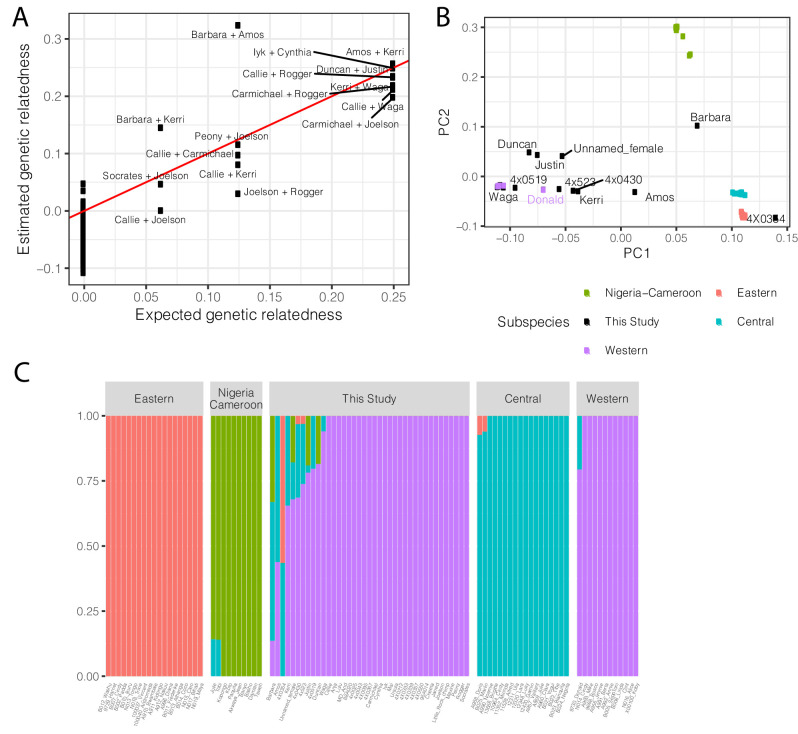
Population structure and relatedness of chimpanzee cohort based on whole genome sequencing genotyping.(A) Scatter plot of the expected and observed genetic relatedness of each pair of chimpanzees for which we have pedigree information. We expected eight first-degree relationships (relatedness = 0.25), five second-degree relationships, and three third-degree relationships. (B) The chimpanzees sequenced in this study are generally Western chimpanzees, although recent admixture with other subspecies is prevalent for many of these captive-born chimpanzees. Principle component analysis of genotypes of newly sequenced and previously sequenced (de Manuel et al., 2016) chimpanzees. Individuals colored by subspecies for previously sequenced chimpanzees (Eastern, Pan troglodytes schweinfurthii; Western, Pan troglodytes verus; Central, Pan troglodytes troglodytes; Nigeria-Cameroon, Pan troglodytes ellioti). Donald is a previously sequenced captive born chimpanzee with known Western-Central admixture (de Manuel et al., 2016). Only newly sequenced chimpanzees with signs of admixture are labelled. (C) Admixture analysis (K = 4) of newly sequenced and previously sequenced chimpanzees. Height of bars indicates group membership. Admixture source data available as Figure 6—figure supplement 2—source data 1.Figure 6—figure supplement 2—source data 1.Admixture group membership of chimpanzees in this study.